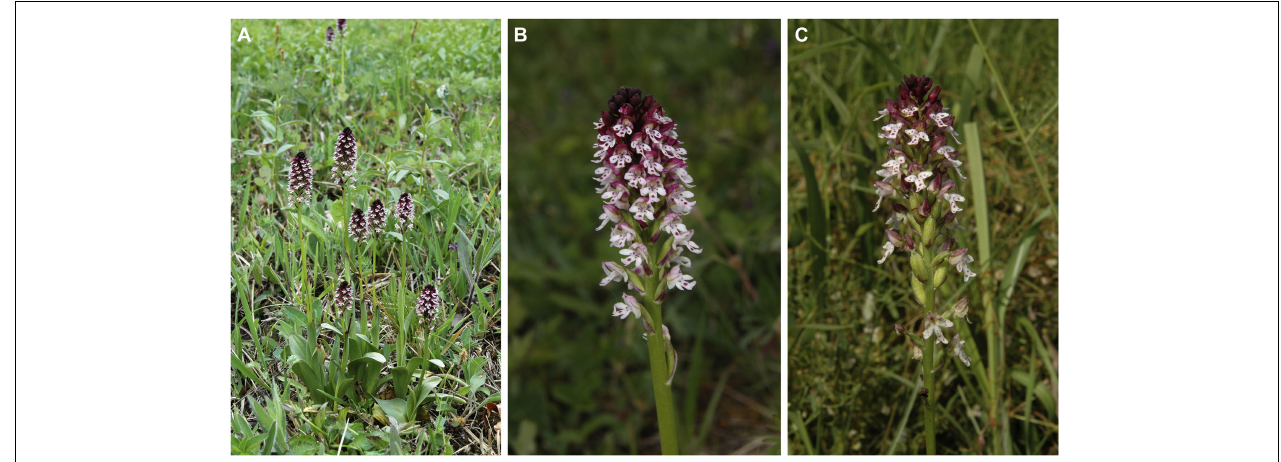
FIGURE 1 | The burnt tip orchid Neotinea ustulata . (A) Habitus of N. ustulata . (B) Inflorescence from a var. ustulata plant. (C) Inflorescence from a var. aestivalis plant. Pictures by J. Jersáková.